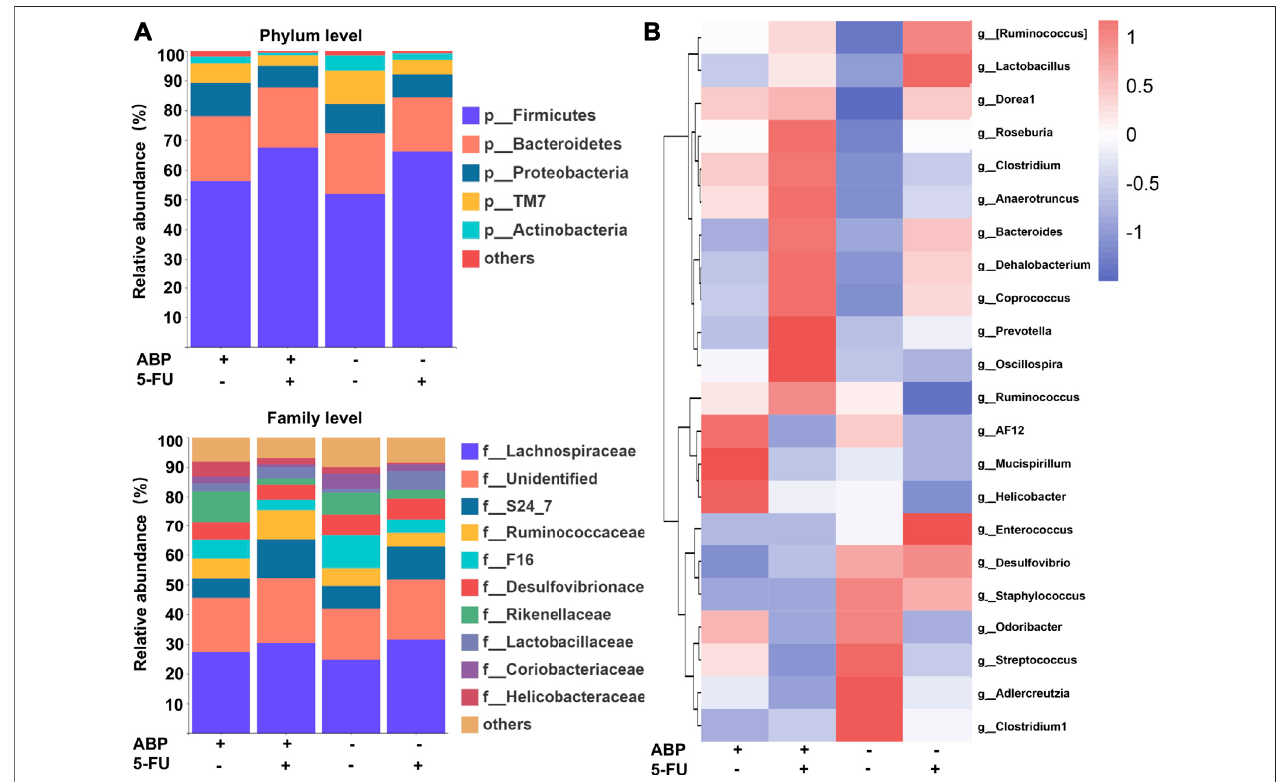
FIGURE 7 | ABP treatment improves the composition of the intestinal micro fl ora. (A) Bar plots of bacterial taxa present in the feces at the phylum and family levels based on relative abundance. (B) Heatmap of bacterial taxa present in the feces at the genus level based on relative abundance.